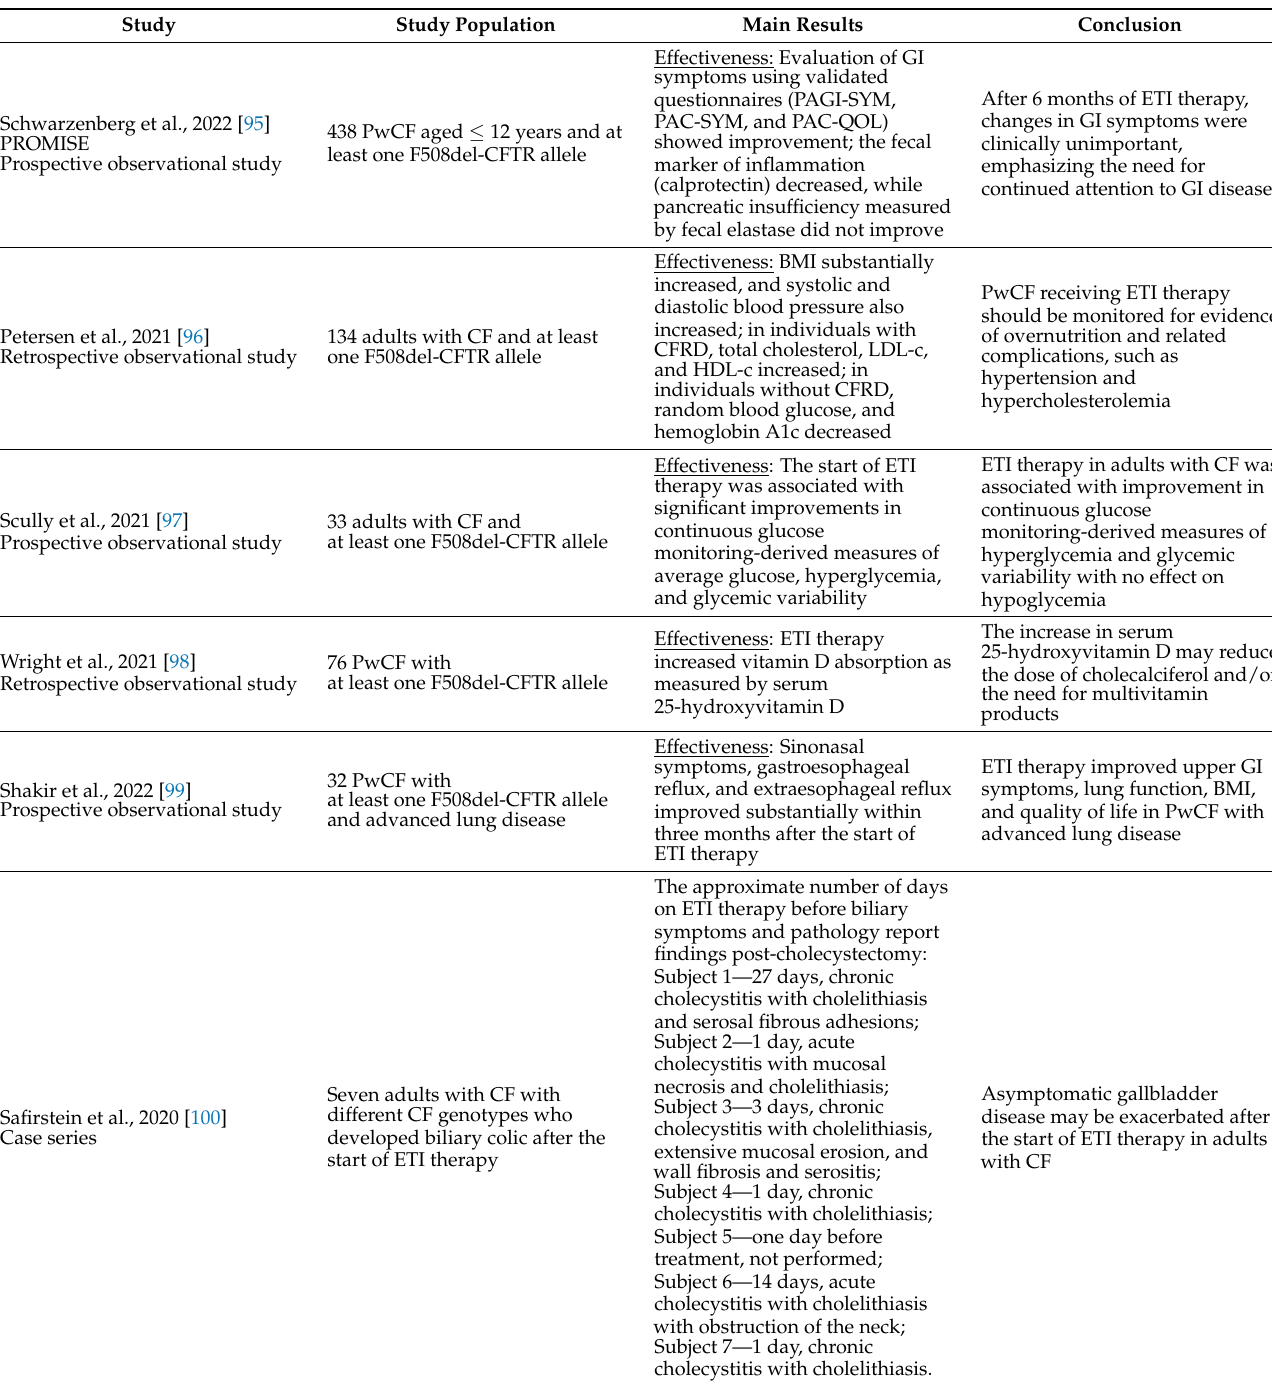
Table 6. Clinical studies assessing the effects of ETI therapy on gastrointestinal symptoms and signs in